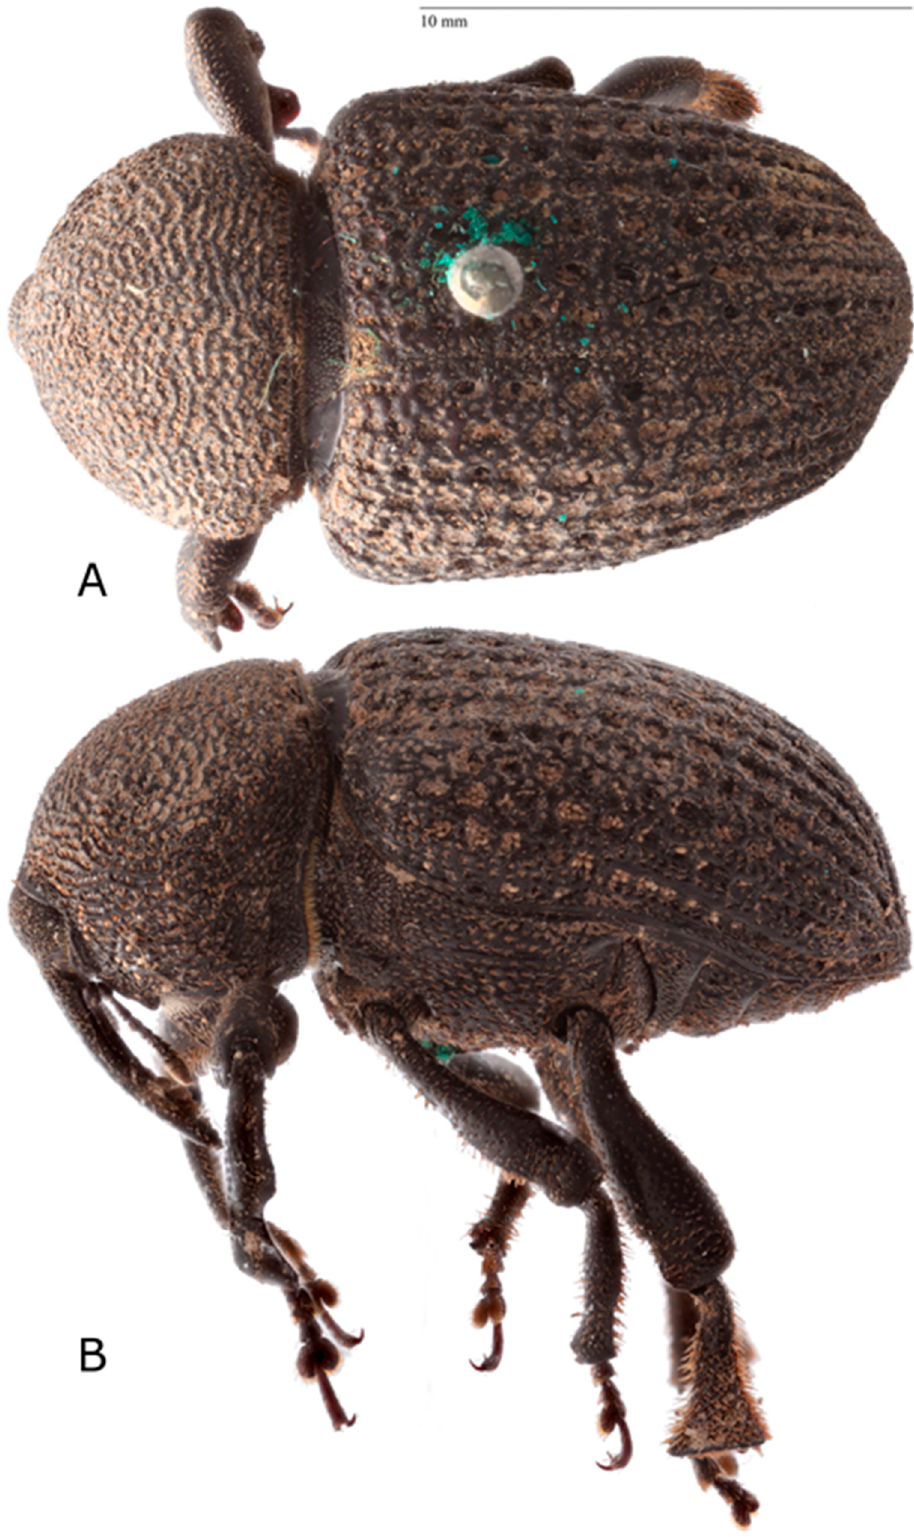
Figure 10. Sclerocardous bohemani Schoenherr lectotype: ( A ) dorsal, and ( B ) lateral. Photographed by Gunvi Lindberg (© 2018 Naturhistoriska riksmuseet). Original photo cropped, light levels and contrast adjusted. Made available by the Swedish Museum of Natural History under Creative Commons Attribution 4.0 International Public License, CC-BY 4.0.